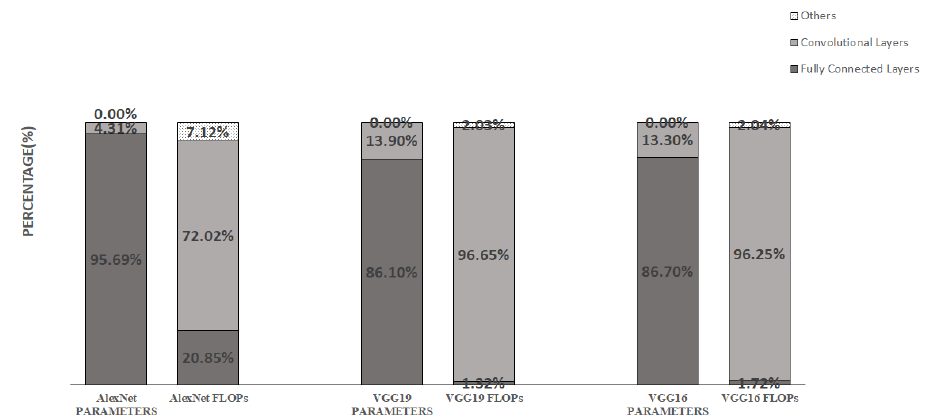
Figure 1. Profiling for convolutional neural